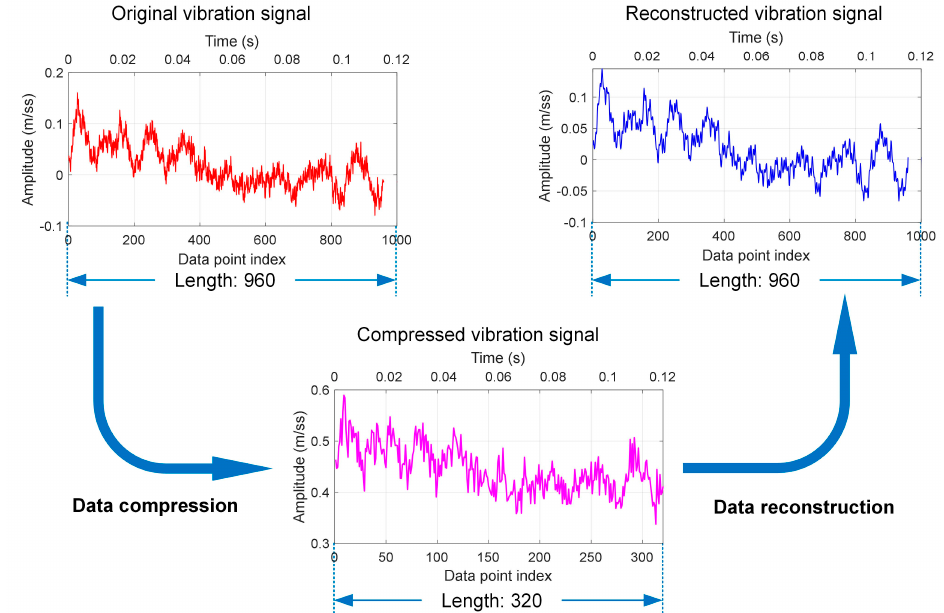
Figure 17. LGPG: vibration signal reconstruction.